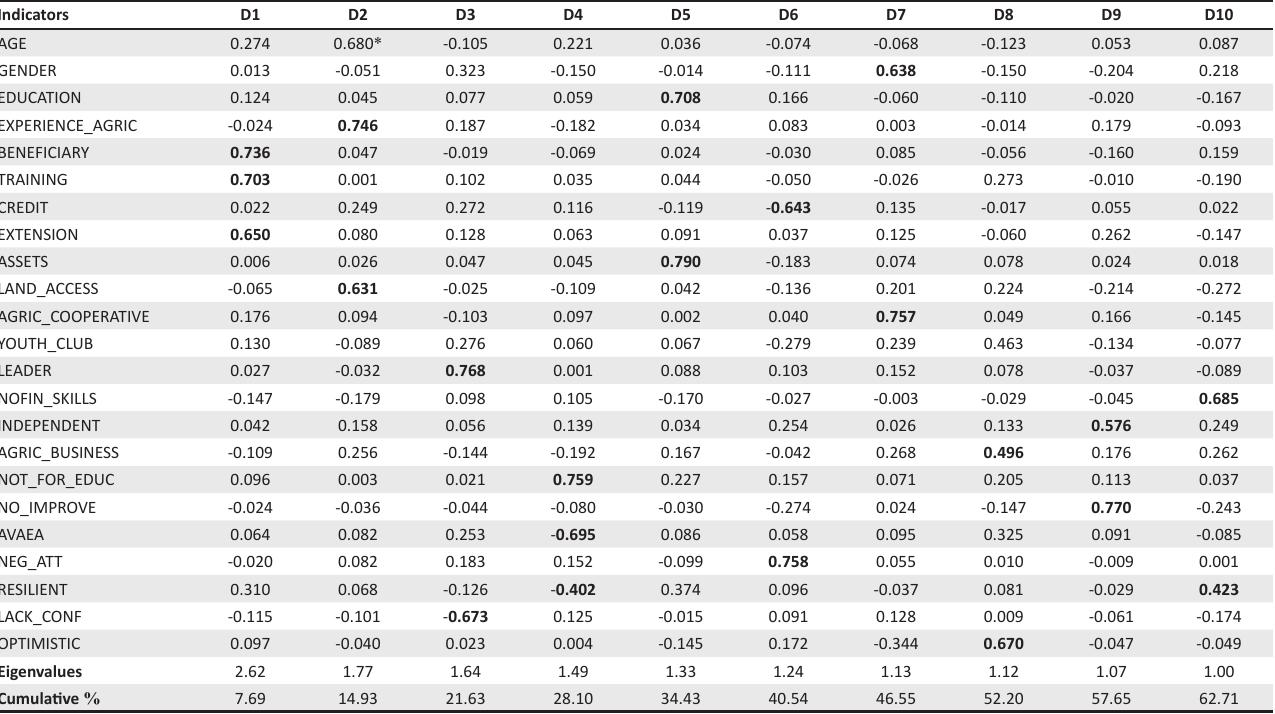
TABLE 4: Principal components analysis results – Dimensions of rural youths’ characteristics. Indicators